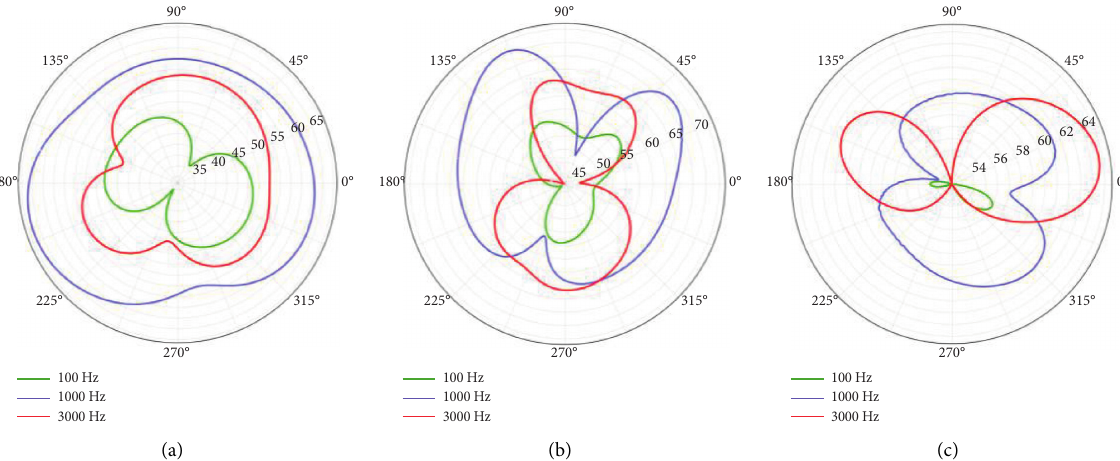
Figure 17: Directional distribution of noise at three frequencies: 100 Hz, 1000Hz, and 3000Hz. (a) x - y plane. (b) x - z plane. (c) y - z